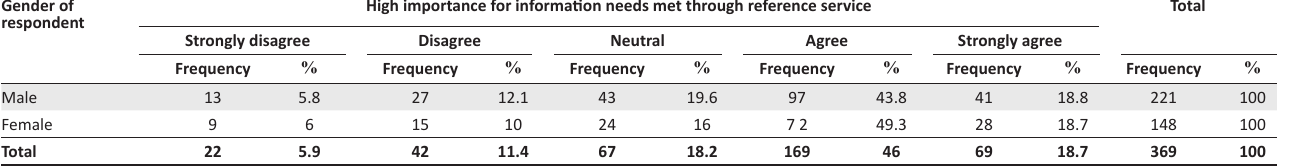
TABLE 4: Gender and importance of information needs to be met through a face-to-face reference service. Gender of